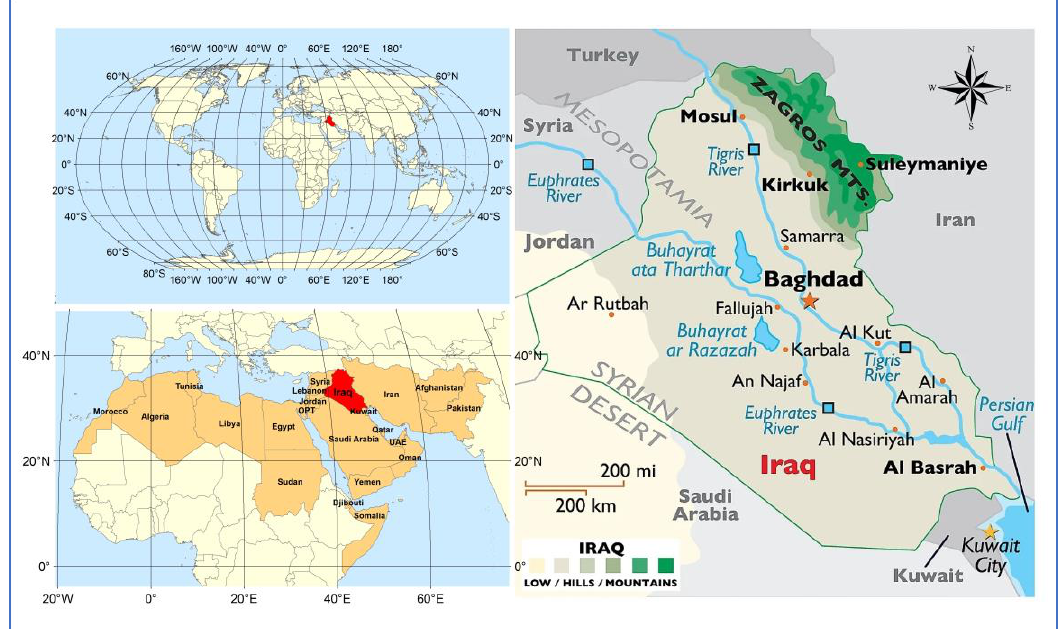
Figure 1. The location of Iraq (red color) and the MENA (brown color) in the world.